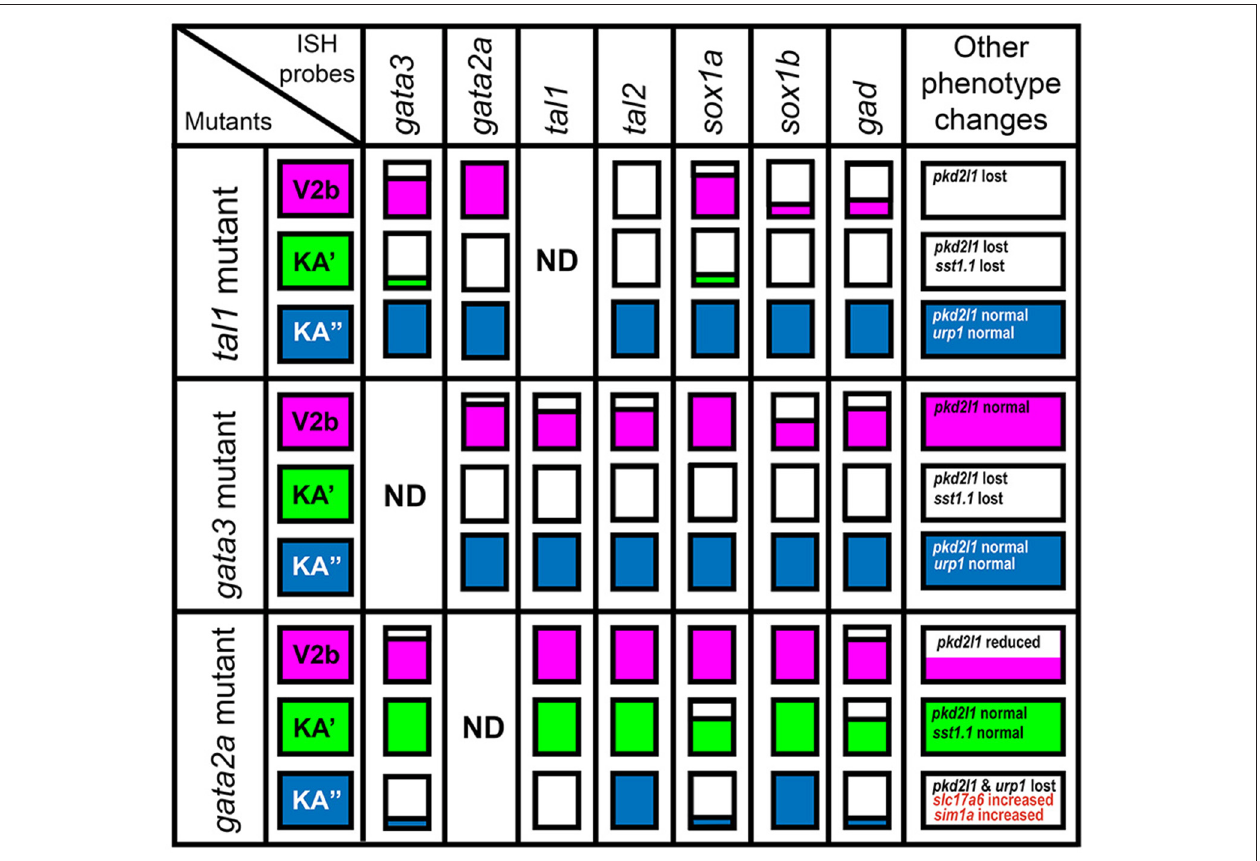
FIGURE 2 | Gene expression phenotypes in gata2a , gata3 , and tal1 mutants. Summary schematic representation of gene expression phenotypes in gata2a , gata3 , and tal1 mutants. Phenotypes are reported for cells in the spinal cord regions where KA ′′ , KA ′ , and V2b cells normally form. The KA ′′ region (blue) corresponds to row 1 cells, the KA ′ region (green) corresponds to all row 2 plus medial row 3 cells and the V2b region corresponds to lateral row 3 cells plus all row 4 and above cells. White boxes indicate that no cells in that spinal cord region express the gene indicated at top of column, in the mutant indicated in the most left hand column. A box filled with color indicates that there is no change in the number of cells expressing that particular gene in that region. A box partially filled with color indicates a partial reduction in the number of cells expressing the gene. The amount of the box that is white is approximately proportional to the degree of reduction. Information on additional genes that are not expressed in all cell types is provided in the final